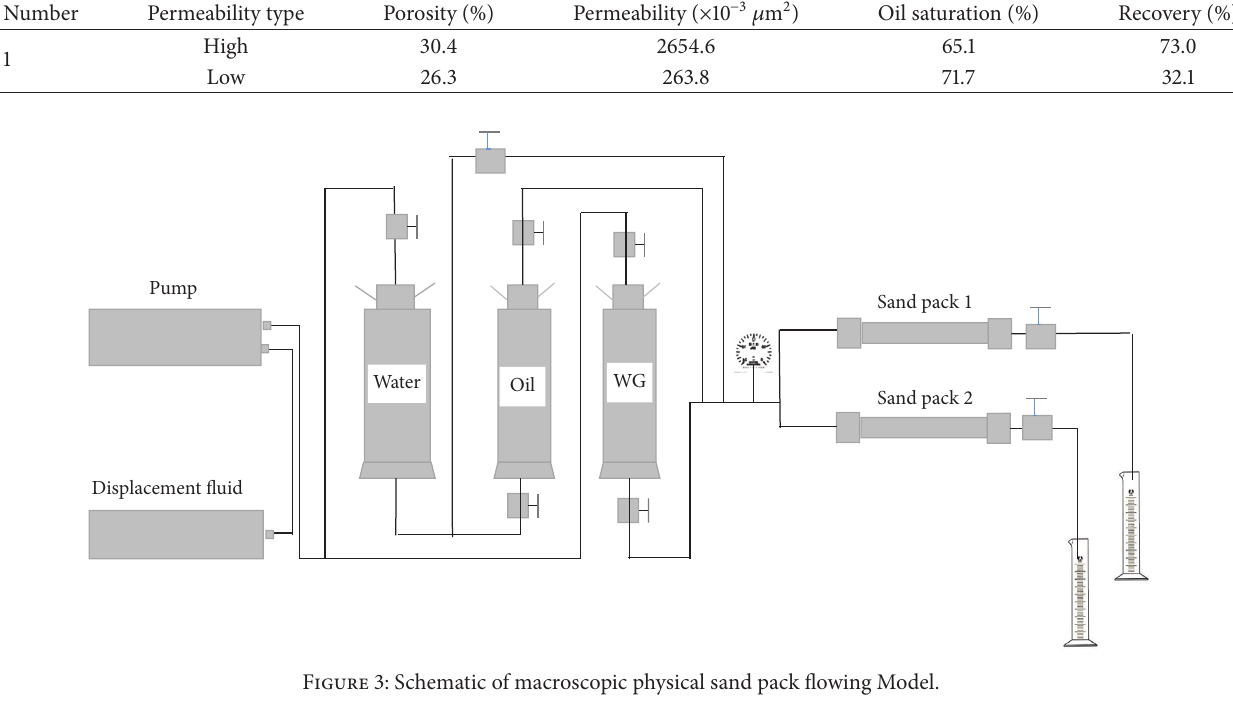
Figure 3: Schematic of macroscopic physical sand pack flowing Model.